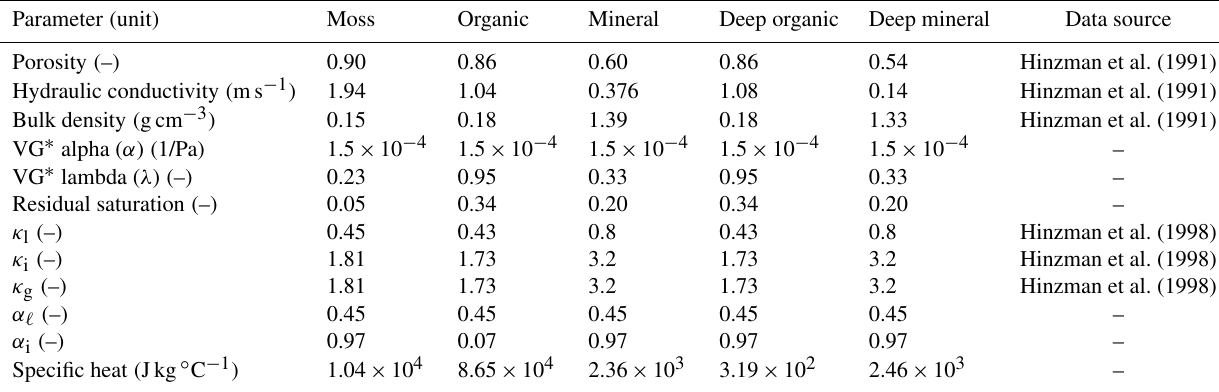
Table D1. Soil hydraulic and thermal properties used in the models. Parameter ( unit